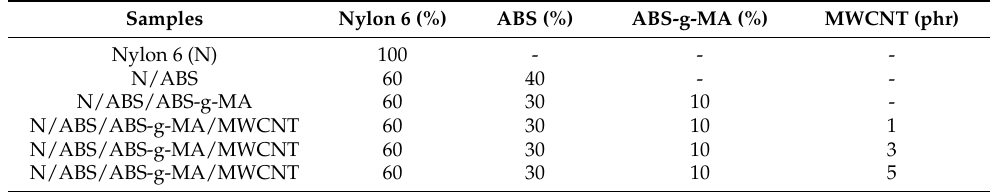
Table 3. Formulations of the processed nanocomposites. Part per hundred of resin (phr); N = Nylon